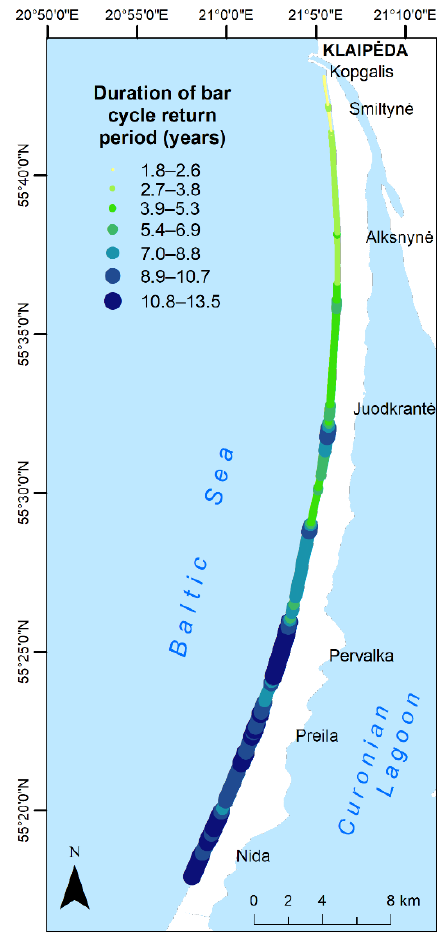
Figure 10. Alongshore variability in the bar cycle return periods ( 𝑇 𝑟